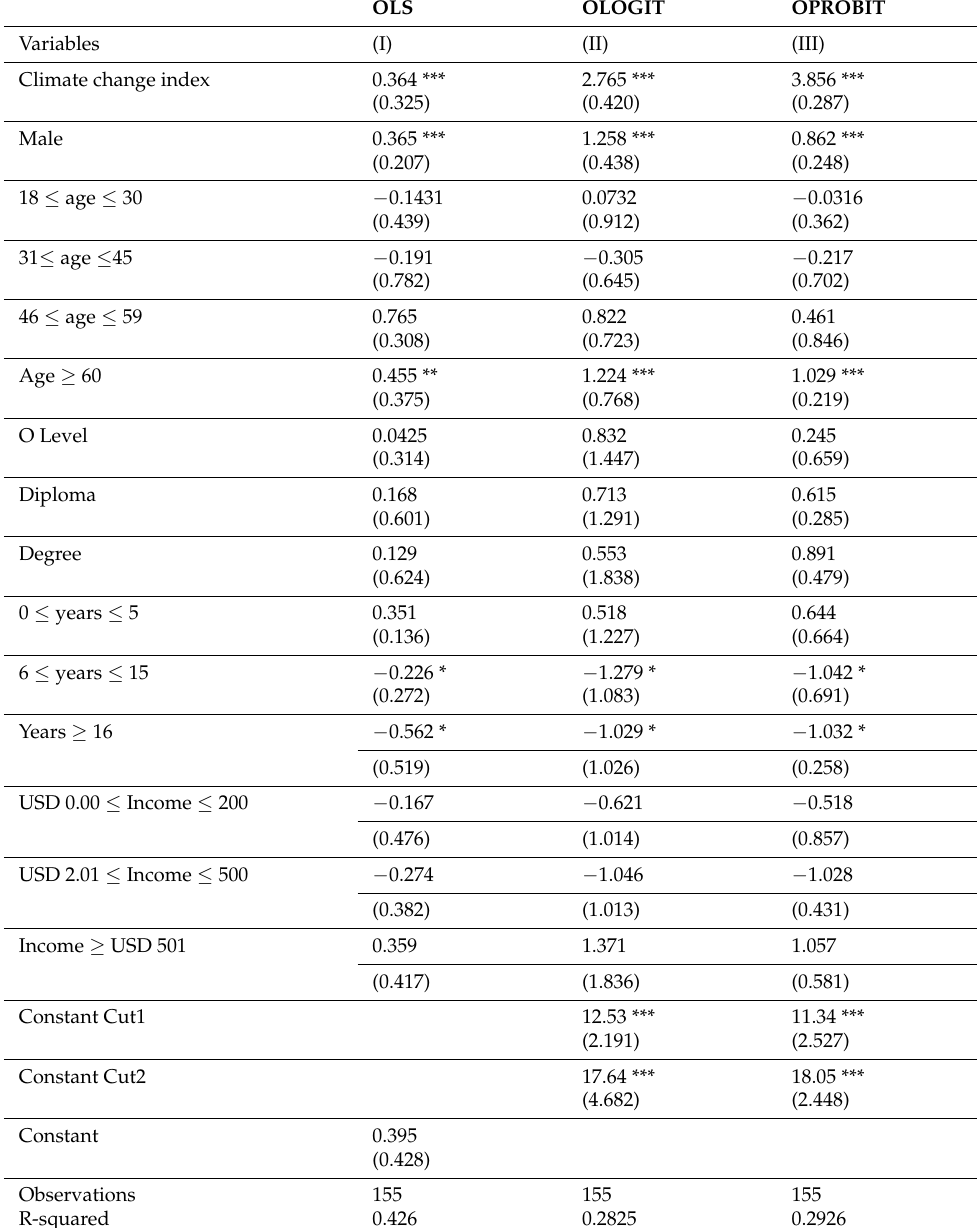
Table 2. OLS, OLOGIT, and OPROBIT estimates: The impact of climate change on the performance of (peri-)urban livestock business in the City of Masvingo,